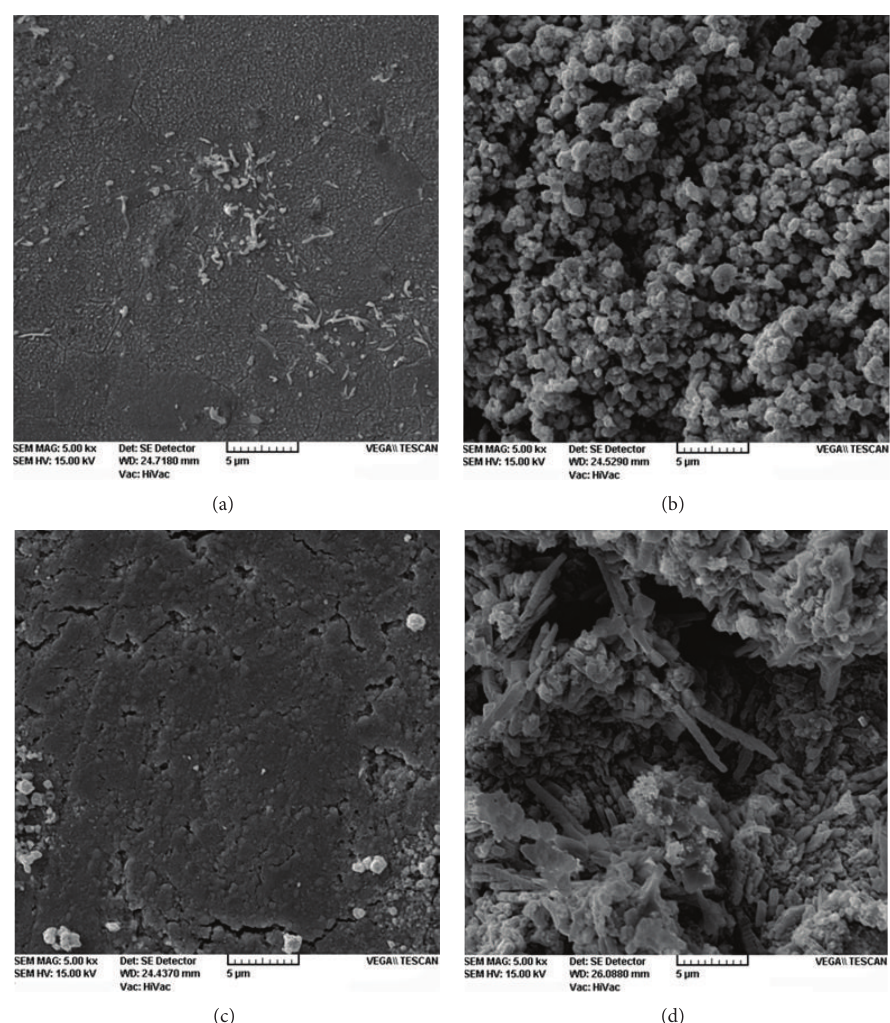
Figure 6: SEM micrographs of lead/silver anodes before (a) and after 72 hours electrowinning process ((b), (c), (d)). The image (d) is taken from the bottom of electrode, which corresponds with the localized damaged area.